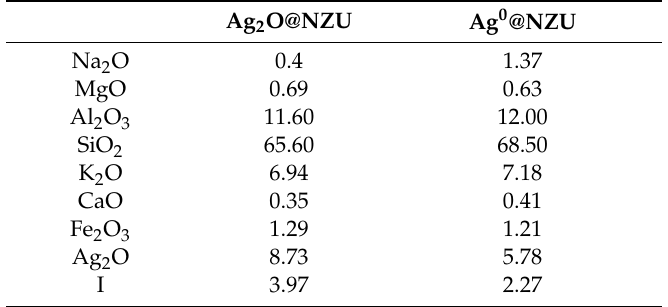
Table 4. XRF analysis results of zeolite samples after iodide adsorption (major elements only, % w / w